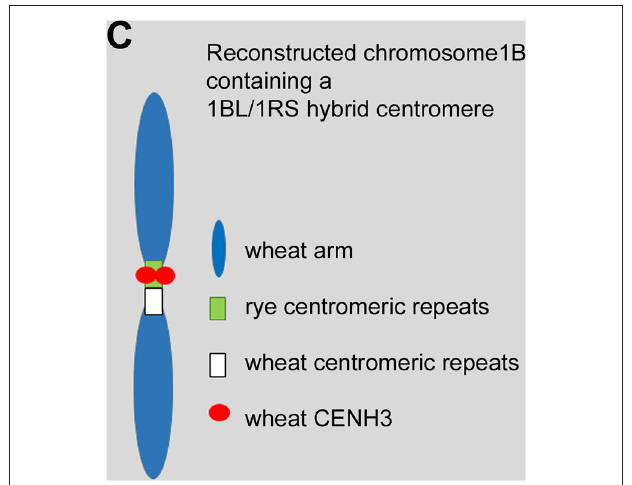
FIGURE 1 | (C) Schematic representation of the reconstructed wheat chromosome 1B with a hybrid wheat-rye centromere. This centromere is composed of wheat and rye centromeric repeats. The wheat-derived CENH3 co-localized only with the rye-derived centromeric chromatin creating a functional